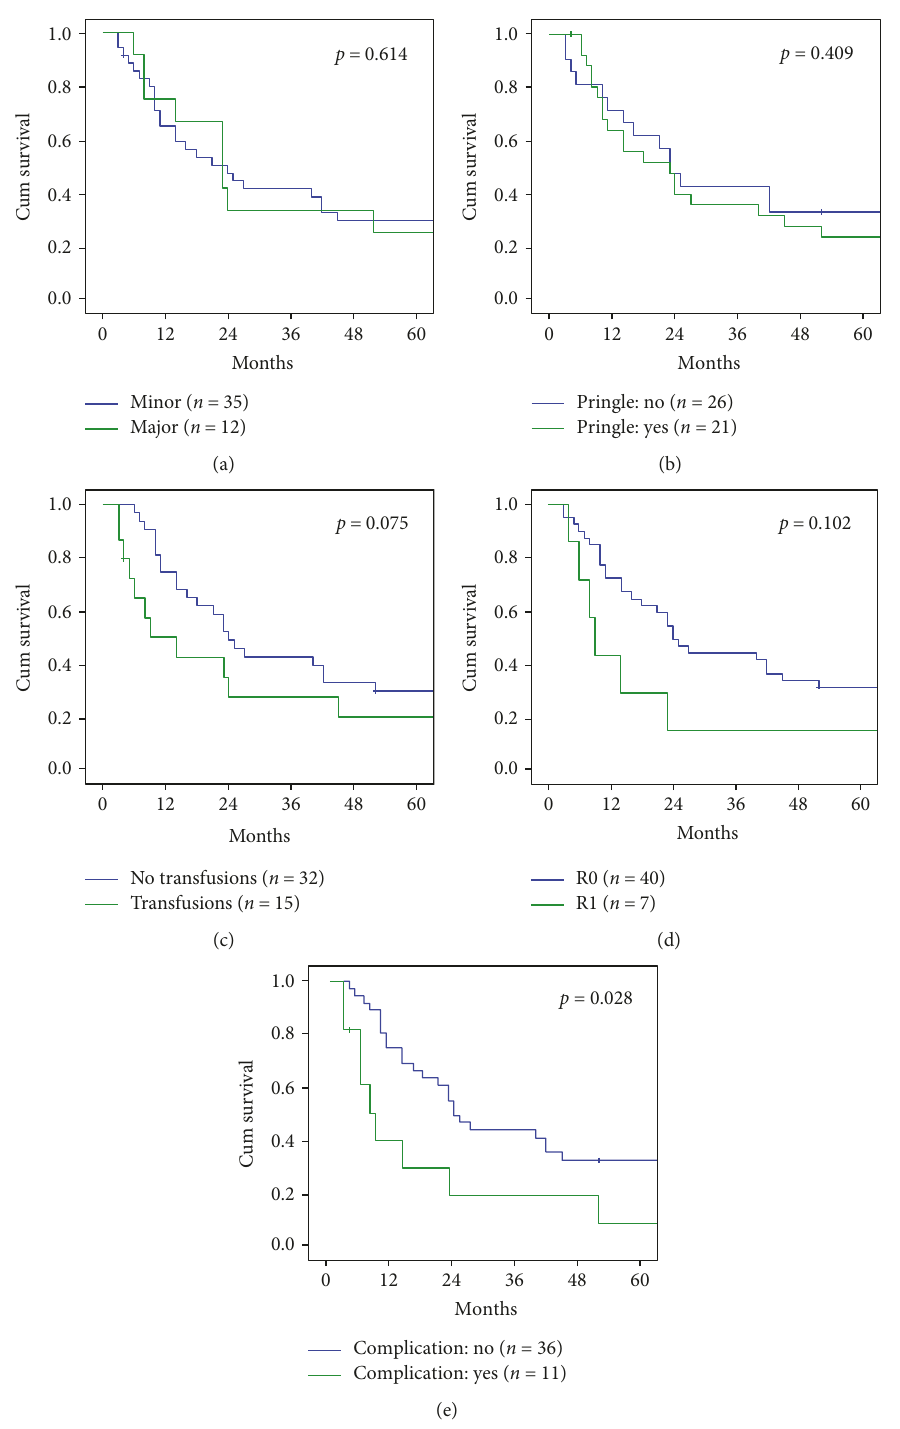
Figure 4: Overall survival according to surgical and oncologic characteristics. (a) Minor versus major resection. (b) Pringle ’ s maneuver: yes versus no. (c) Transfusion: yes versus no. (d) Resection margins R0 versus R1. (e) Postoperative complication: yes versus